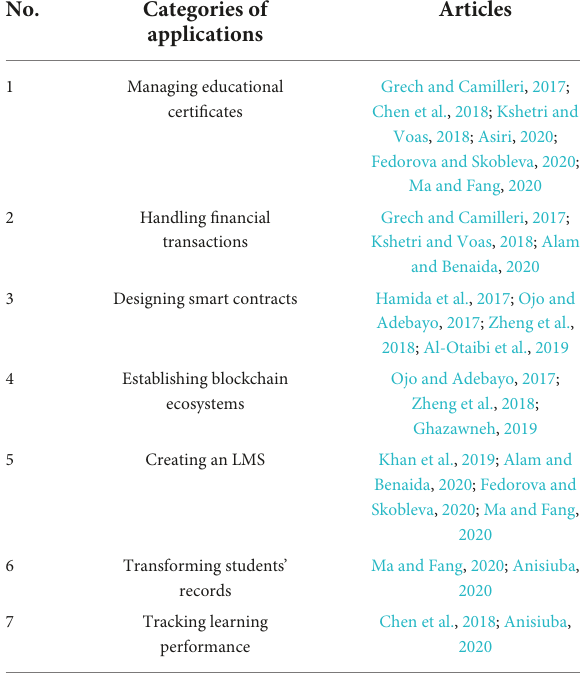
TABLE 5 The seven applications of blockchain technology in